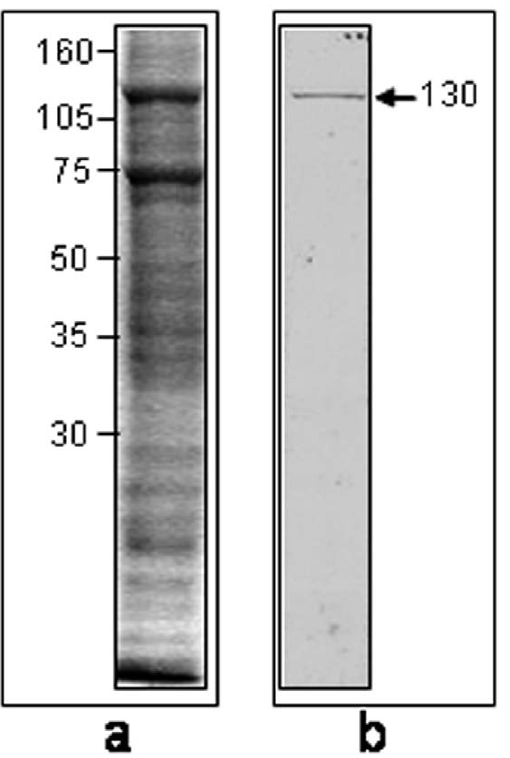
Figure 4. 2D SDS-PAGE and corresponding ligand blotting that show the binding of live parasites to the 130 kDa polypeptide spot present in the total protein extract of Oncopeltusfaciatus salivary glands. ( A ) 2D SDS-PAGE of total protein extract from salivary glands stained with Coomassie Blue. The arrow indicates spots at the 130 kDa region. The numbers on the horizontal axis refer to the pH gradient (pI) and the numbers on the vertical axis refer to the molecular mass standard expressed in kilodaltons. ( B ) Ligand blotting showing one spot at the 130 kDa region. The spot on the PVDF membrane indicates the binding of biotinylated live parasites to the 130 kDa protein. For further details see the Methods.